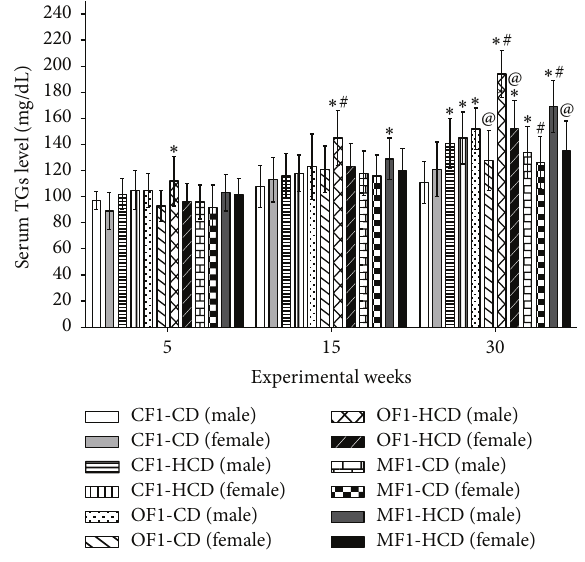
Figure 4: Serum levels of triglycerides (TGs) (mg/dL) of all study groups. Data are presented as mean ± SD ( 𝑛 = 10 ). CF1-CD: F1 offspring of control mothers under control diet, CF1-HCD: F1 offspring of control mothers under high-caloric diet, OF1-CD: F1 offspring of obese mothers under control diet, and OF1-HCD: F1 offspring of obese mothers under high-caloric diet; MF1-CD: F1 offspring of malnourished mothers under control diet and MF1- HCD: F1 offspring of malnourished mothers under high-caloric diet. The symbol ∗ indicates significant difference from CF1-CD by ANOVA ( 𝑝 < 0.05 ), the symbol # indicates significant difference from CF-HCD by ANOVA ( 𝑝 < 0.05 ), and the symbol @ indicates significant difference from male at each age by 𝑡